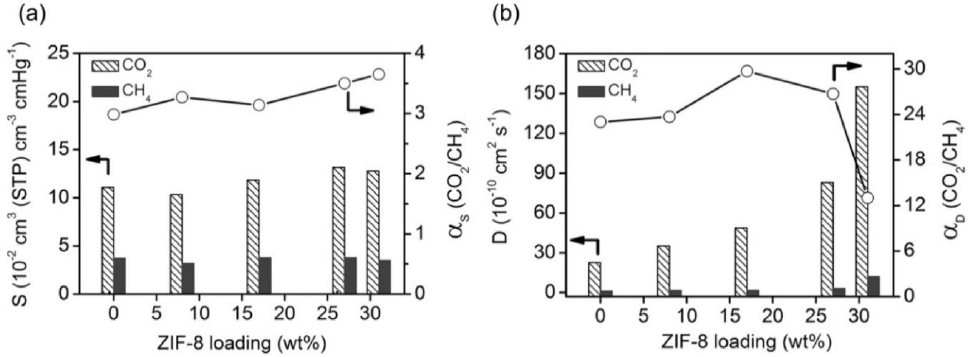
Figure 3. Effect of ZIF-8 loading on the solubility and the diffusivity selectivity when embedded in P84 polyimide [55], with copyright permission from © 2018 Elsevier.